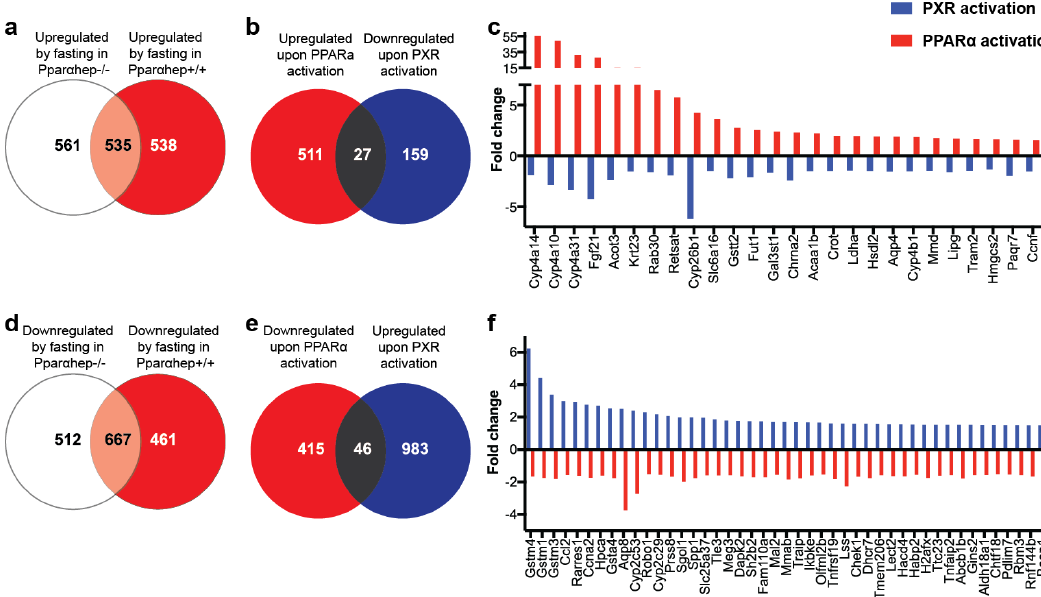
Figure 3. Comparison between PXR and peroxisome proliferator-activated receptor α (PPAR α ) target genes. ( a , d ) Venn diagrams representing the number of genes up-( a ) or down-( d ) regulated upon fasting in Ppar α hep +/+ vs. Ppar α hep- / - mice. ( b , e ) Venn diagrams representing the number of genes regulated upon PPAR α (red) or PXR (blue) activation. ( c , f ) Fold-changes for the genes that are shared in the previous Venn diagrams.